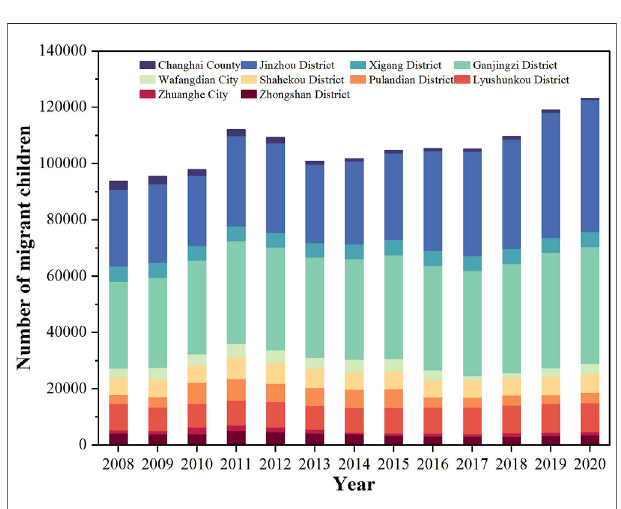
FIGURE2| Statisticalchartofchangesinthenumberofmigrantchildren in Dalian from 2008 to 2020.